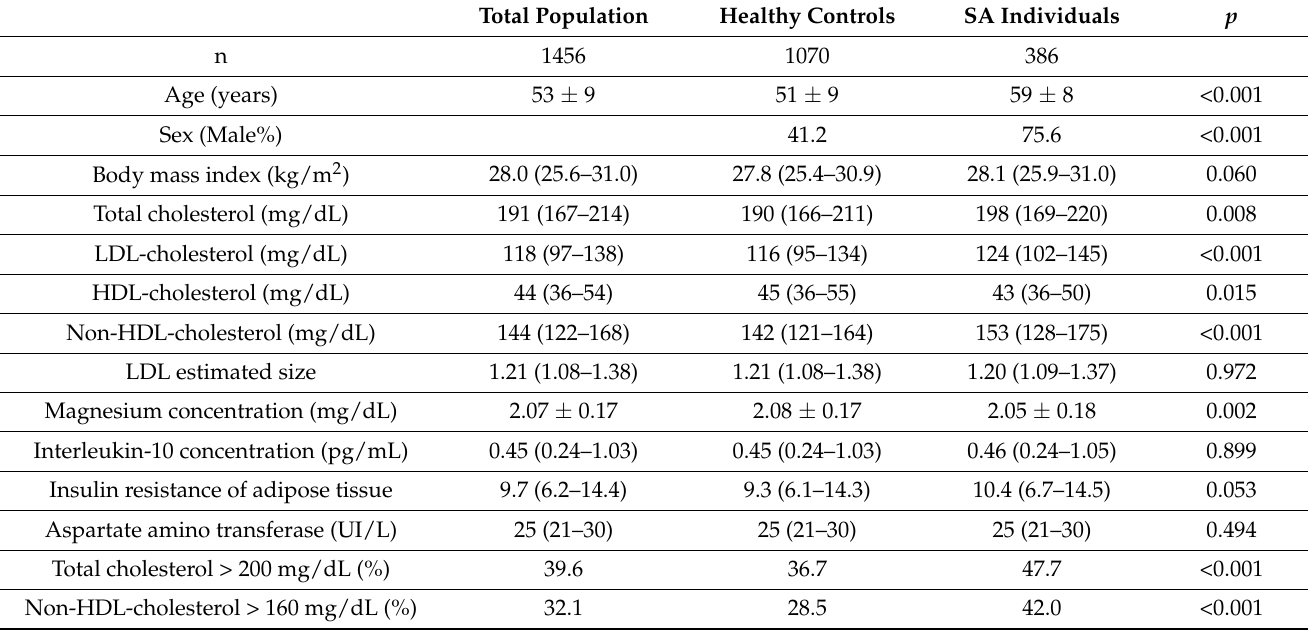
Table 1. Demographic, clinical, biochemical characteristics, and frequencies of FOXA3 polymorphisms. Total